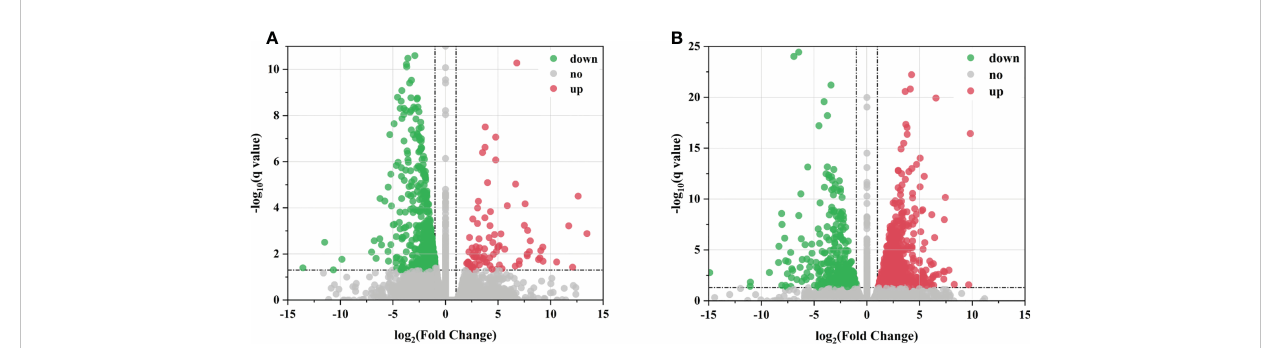
FIGURE 2 Differentially expressed genes (DEGs) of sugar beet under LN treatment. (A, B) Volcano plot of DEGs in leaves and roots between the control and low N treatments, respectively. The x-axis represents changes in gene expression ploidy across LN stress; the y-axis represents statistically signi fi cant differences in gene expression. Scattered dots represent individual genes; gray dots indicate no signi fi cant differences in transcripts, red dots indicate signi fi cant differences in downregulated genes, and green dots indicate signi fi cant differences in upregulated genes.